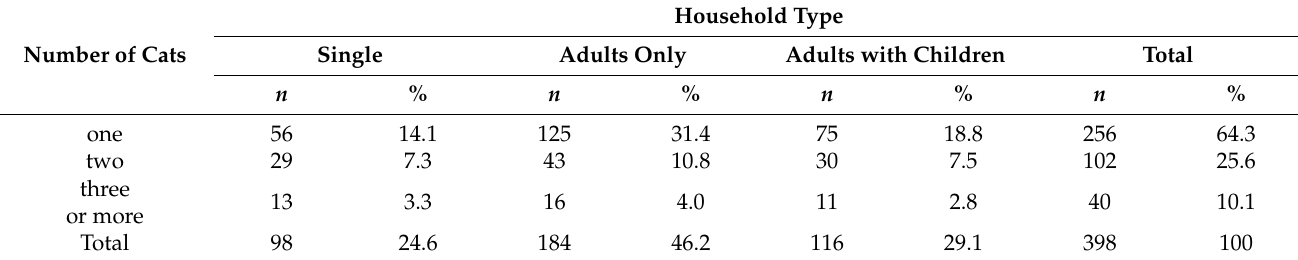
Table 3. Households characteristics vs. number of cats